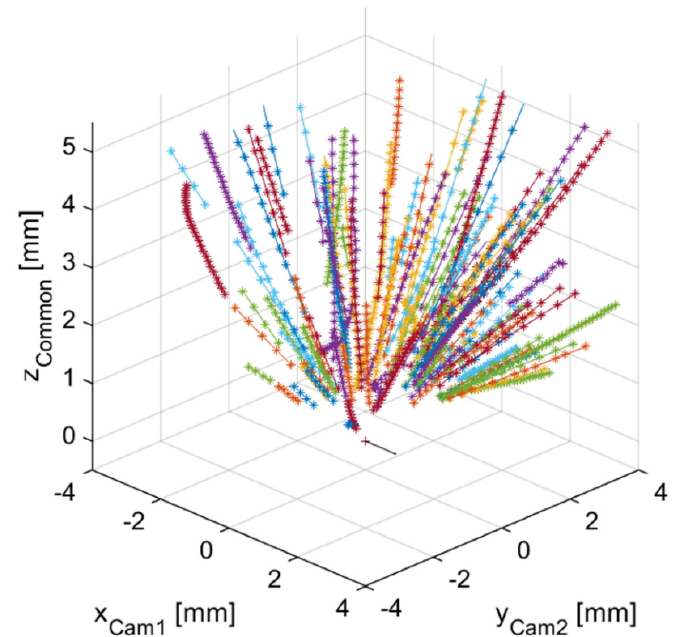
Figure 3. 3D plot of 119 reconstructed spatter tracks for pure aluminum Al99.5 (the keyhole opening is located at the origin of the coordinate system, the little arrow illustrates the positive x -direction and the welding direction).